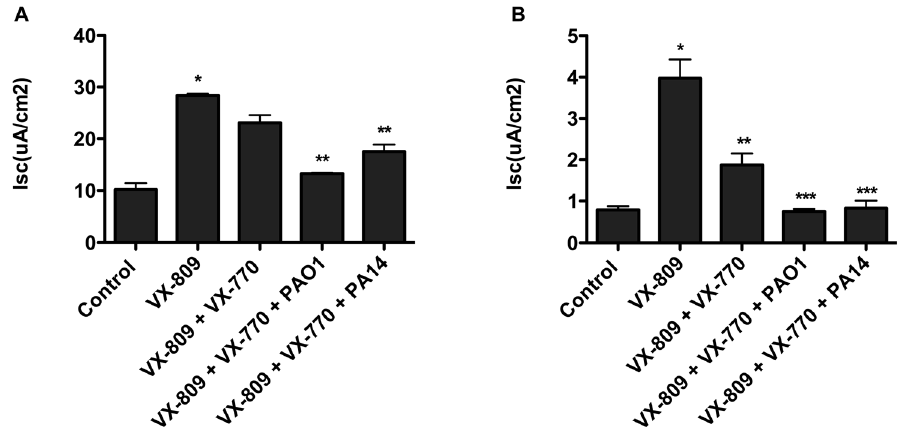
Fig 5. Effect of P . aeruginosa on F508del-CFTR Cl secretion in CFBE cells (A) and CF-HBE cells (B) treated with VX-809 alone and VX-809 + VX-770. VX-770 (5 μ M) did not significantly alter VX-809 (3 μ M) stimulated Cl secretion in CFBE cells. Both PAO1 and PA14 reduced VX-809 + VX-770 stimulated Cl secretion in CFBE cells. By contrast VX-770 significantly reduced VX-809 stimulated Cl secretion in CF-HBE cells. As in CFBE cells both PAO1 and PA14 reduced the VX-809 + VX-770 stimulated Cl secretion. * P < 0.05 versus control. ** P < 0.05 versus VX-809. *** P < 0.05 versus VX-809 + VX-770. N = 3 to 6/treatment for CFBE cells. For CF-HBE cells, N = 3 donors, from each donor 3 to 7 monolayers of cells were studied/